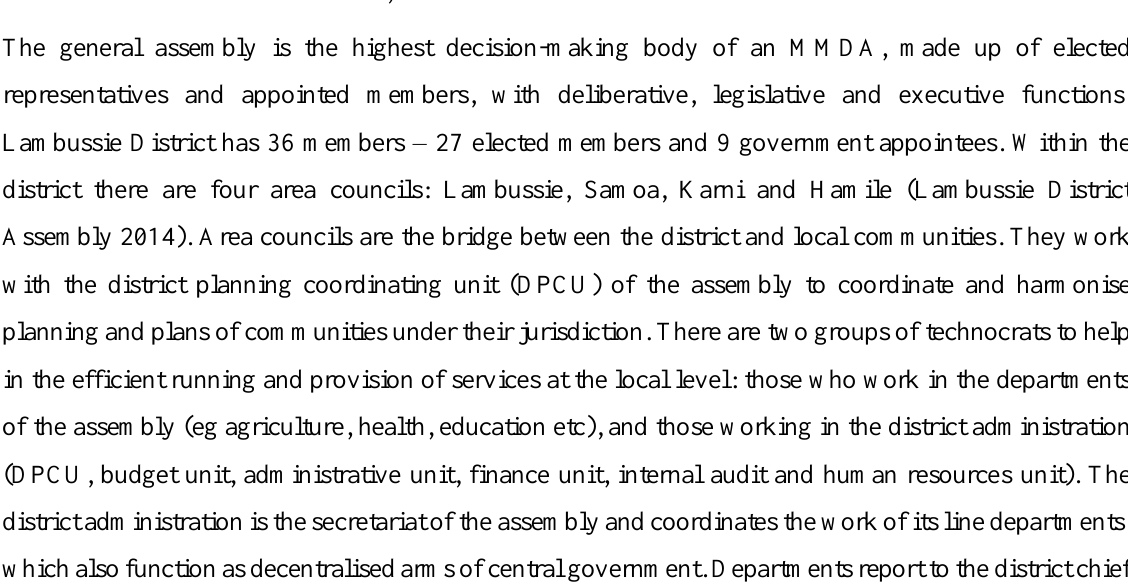
Source: Authors' construct,